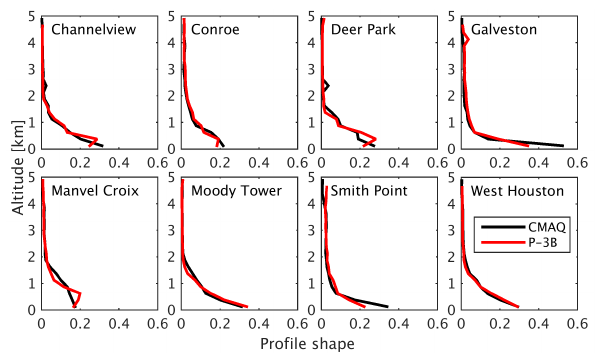
Figure 9. Normalized median profile shapes from CMAQ model simulations and P-3B aircraft NO 2 observations at P-3B spiral lo- cations during the DISCOVER-AQ Texas campaign. The profiles use model output and observations binned to a 250m altitude grid.